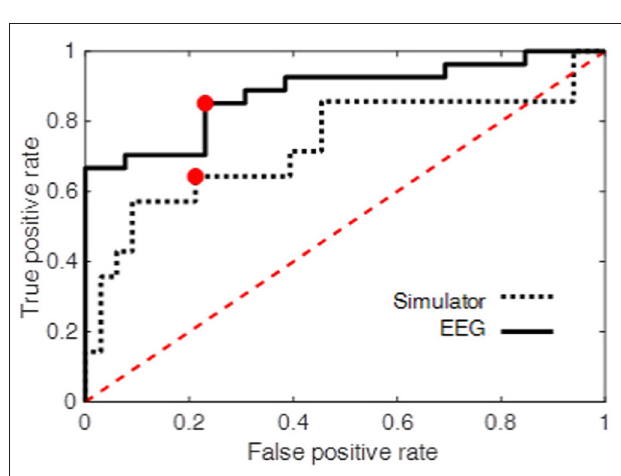
FIGURE 10 | Receiver operating curve (dotted line, simulator; solid line, 3CVT EEG ERP).